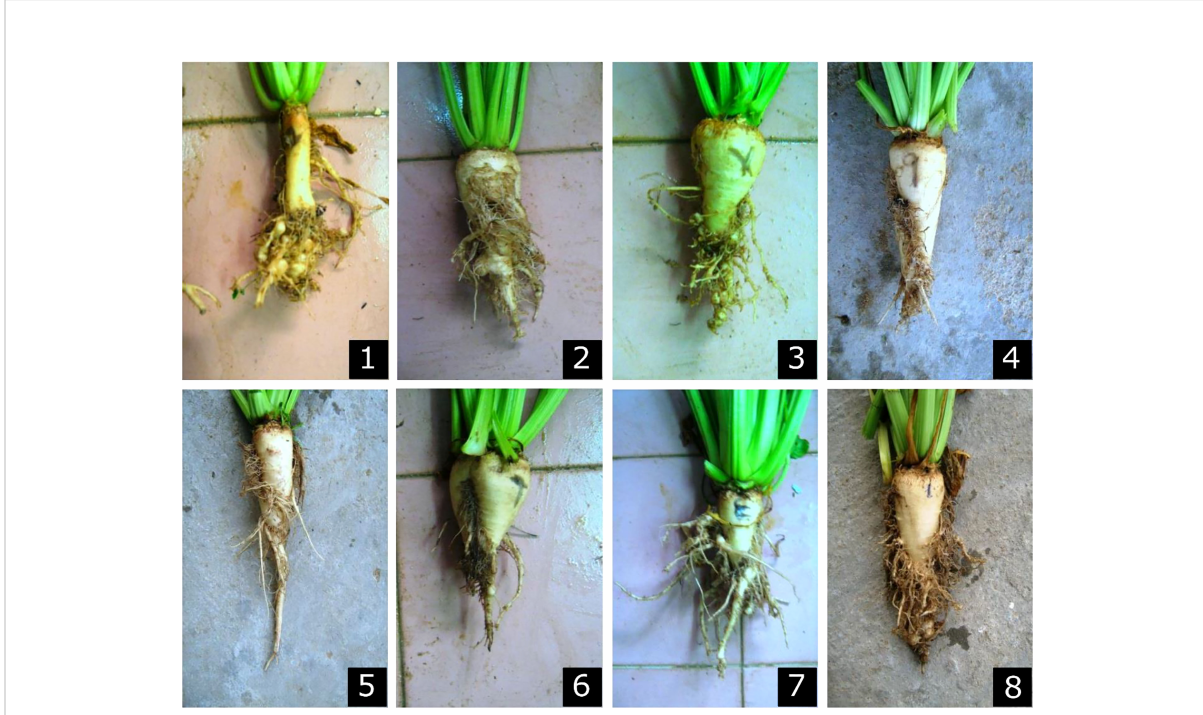
FIGURE 5 Sugar beet roots, 60-days post inoculation with Meloidogyne incognita in eight genotypes; (1) Natura KWS, (2) FARIDA, (3) Lammia KWS, (4) SVH 2015, (5) Lilly, (6) Halawa KWS, (7) Polat, and (8) Capella.